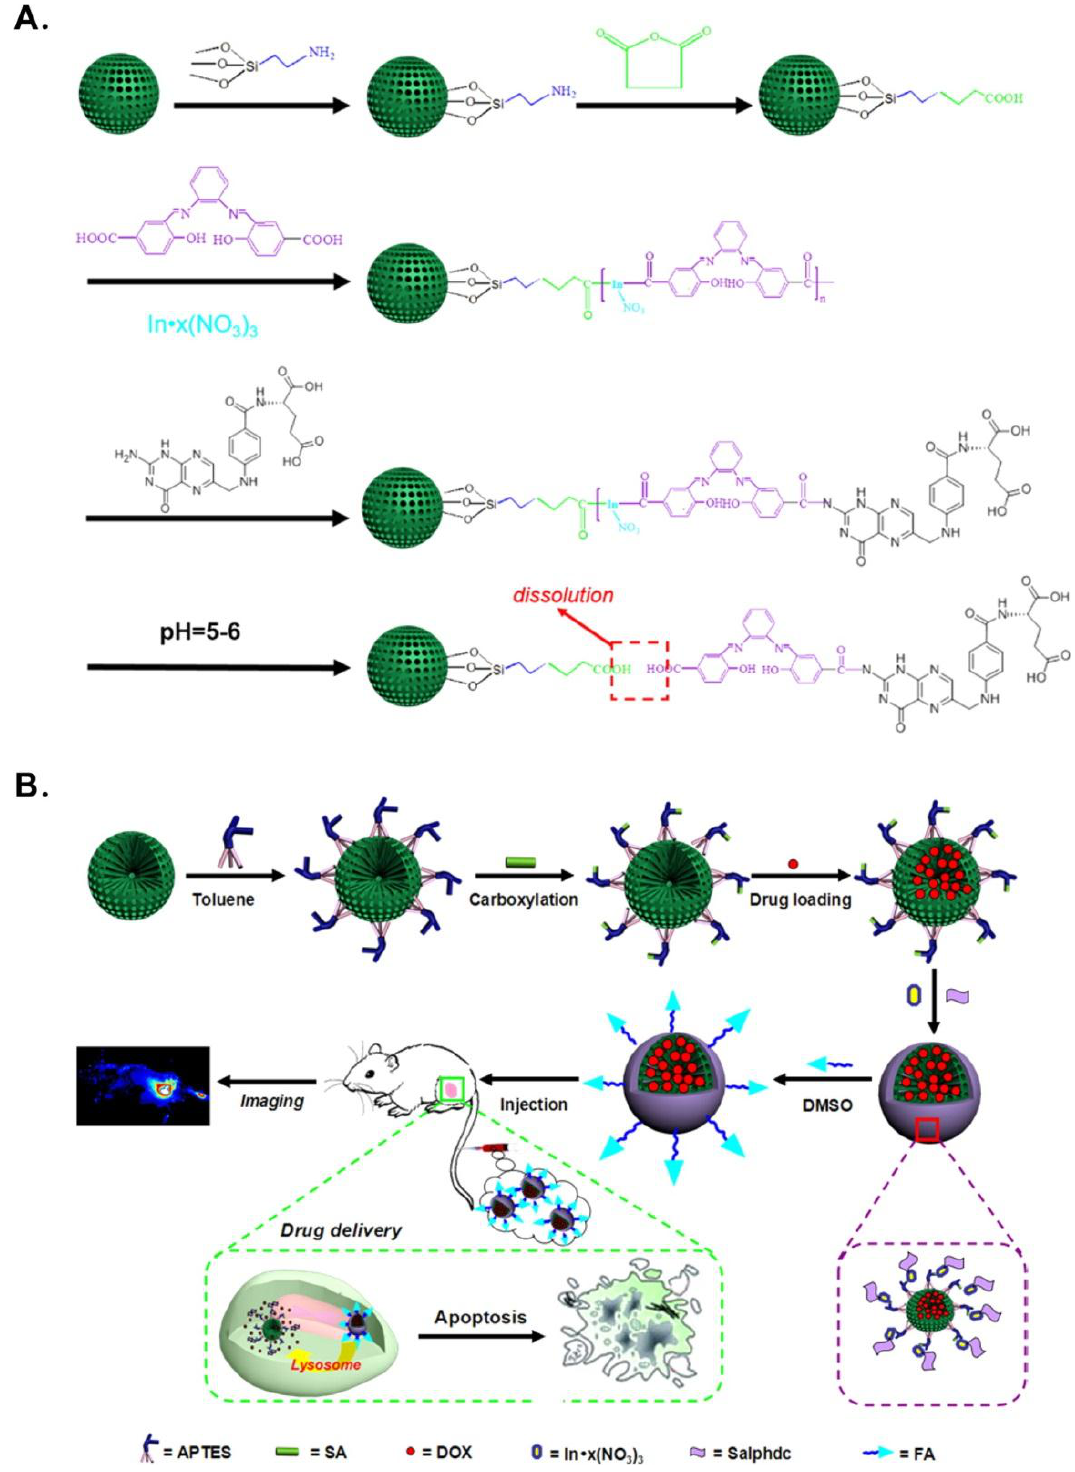
Figure 3. ( A ) Chemical reaction routes of pH-responsive hierarchical poreSiNP (HPSN)- N , N -phenylenebis(salicylideneimine)dicarboxylic acid (Salphdc)-folate (FA) nanosystem; ( B ) the tumor therapy and bioimaging in vivo of the drug-loaded HPSN-Salphdc-FA nanosystem. Reproduced with permission from [39]. Copyright 2015 American Chemical Society.